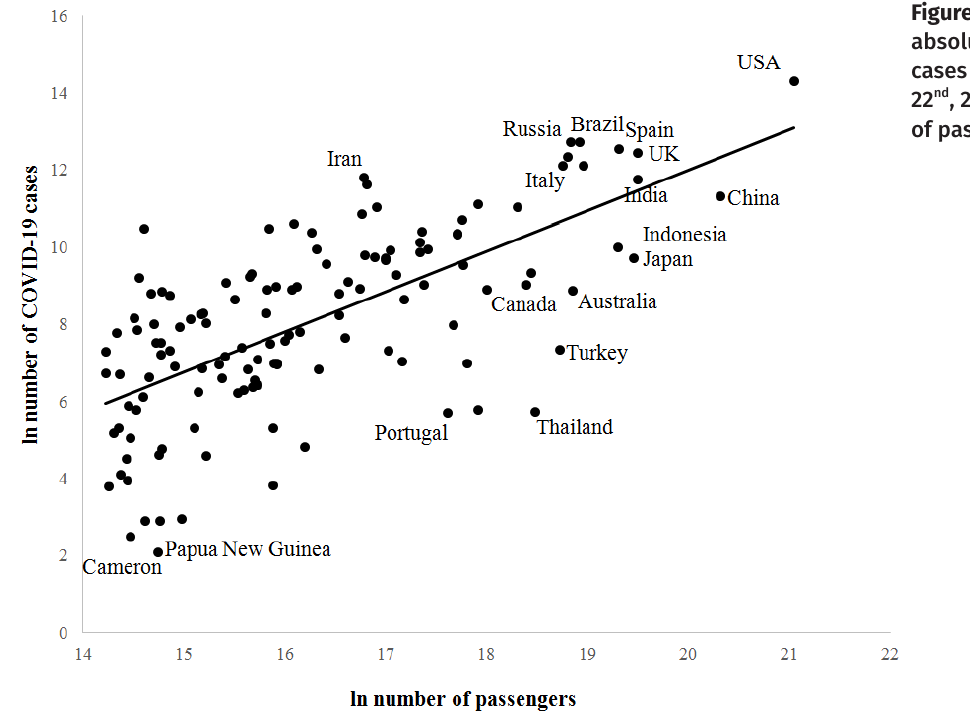
Figure 1. Number absolute of COVID-19 cases per country on May 22 nd , 2020, by the number of passengers in